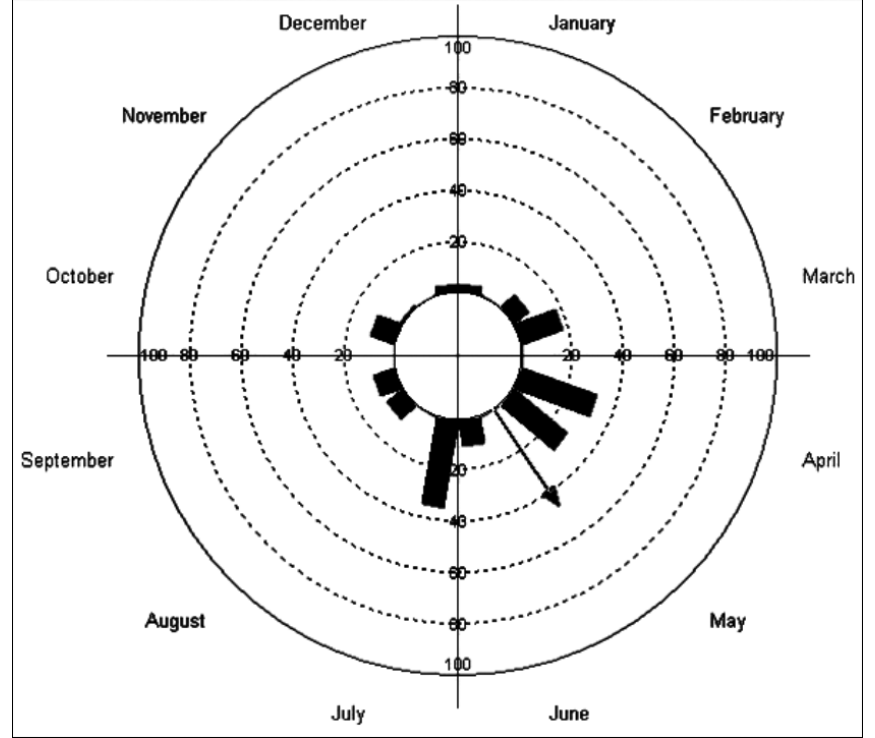
Fig. 2 – Cumulative circular histogram for flowering periods of ornithophilous species in two habitats of Serra da Bodoquena from June 2005 to July 2006. The axis indicates frequency scale, and the bars indicate the frequency of flowering individuals in the guild of ornithophilous species in every month. The arrow indicates mean flowering